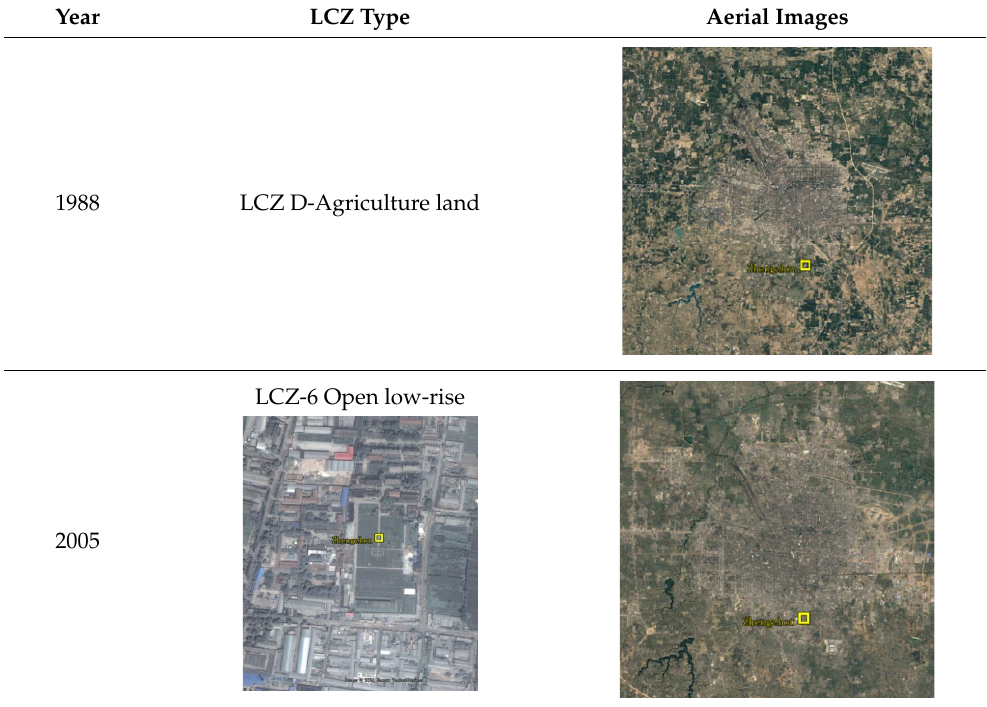
Table A1. Zhengzhou national weather station LCZ.